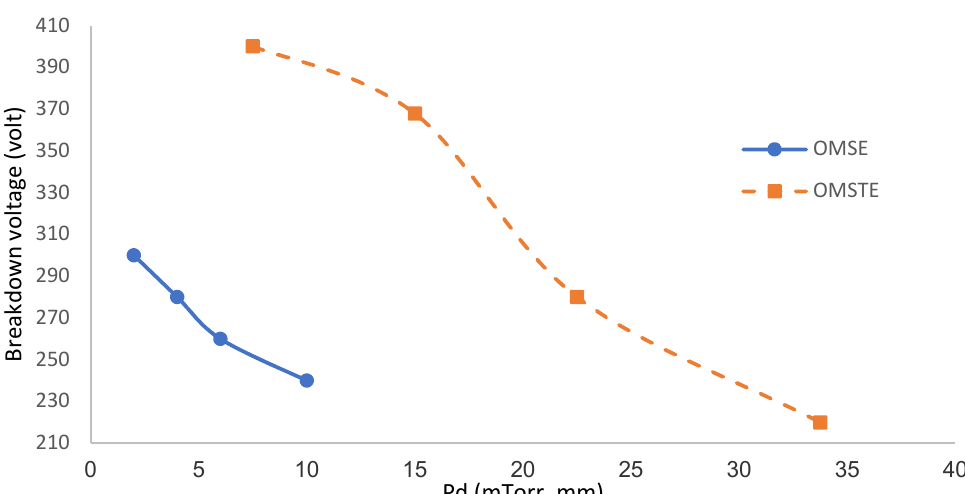
Figure 5. Paschen curve for OMSE and OMTSE, the breakdown voltage V B as a function of Pd (mTorr. mm).